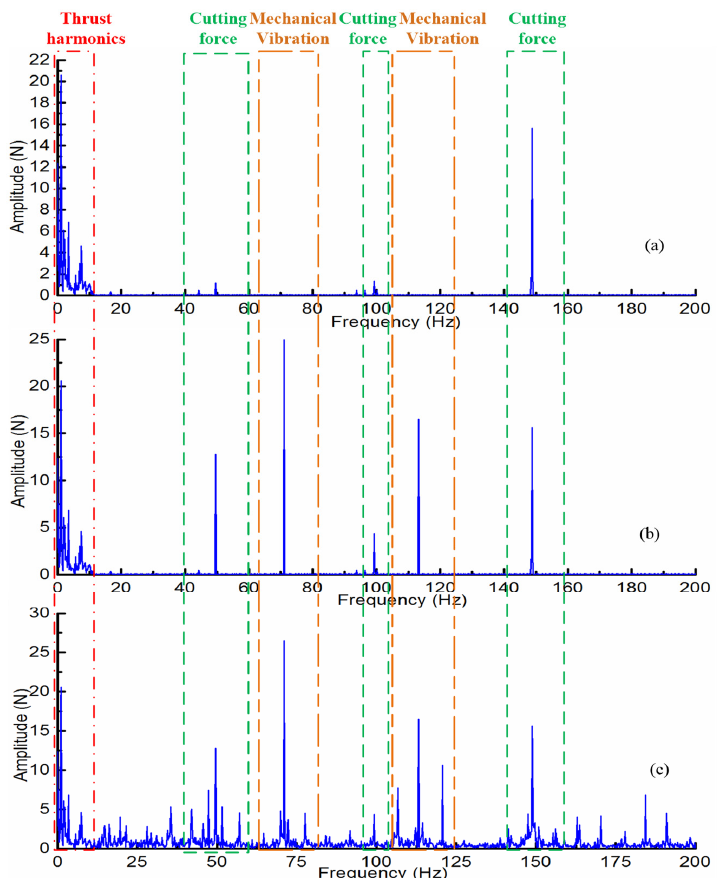
Figure 8. Thrust spectrum of PMLM with different